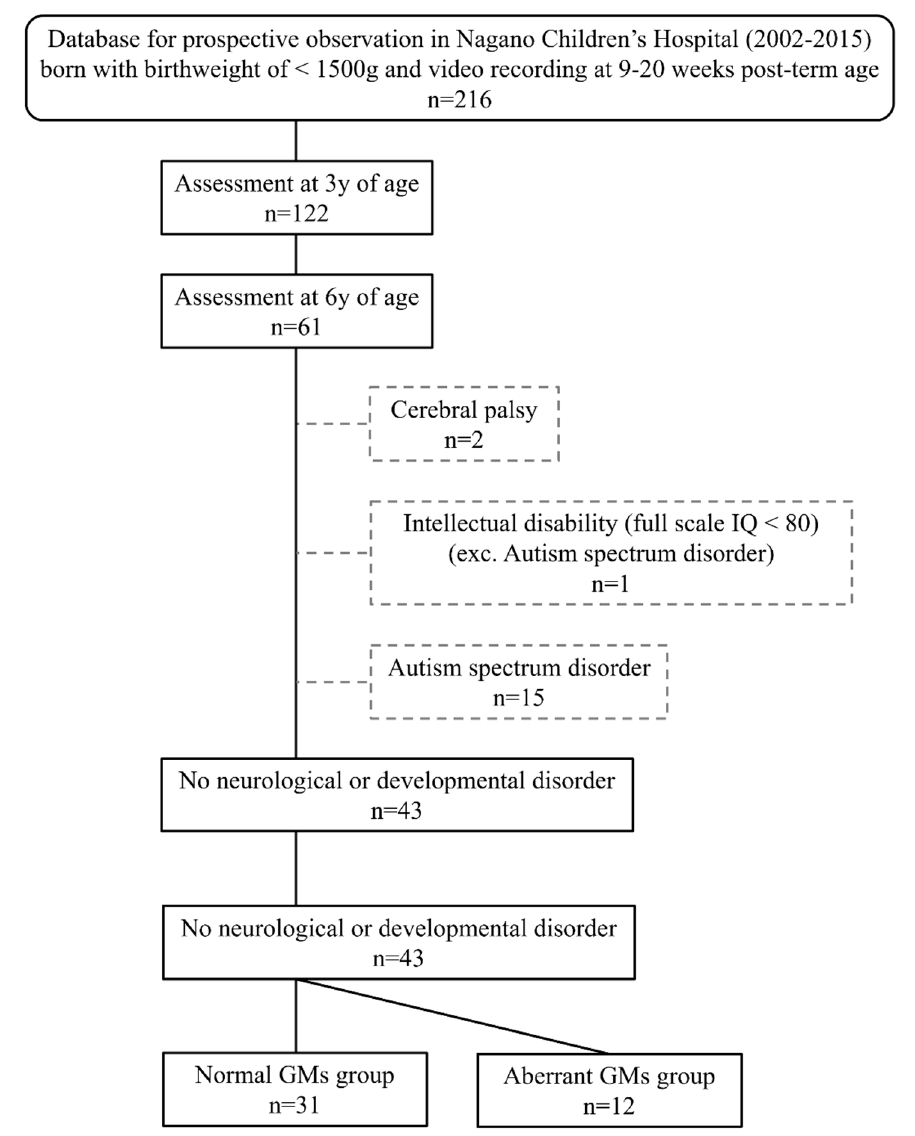
Figure 1. Flow diagram of participant enrolment.